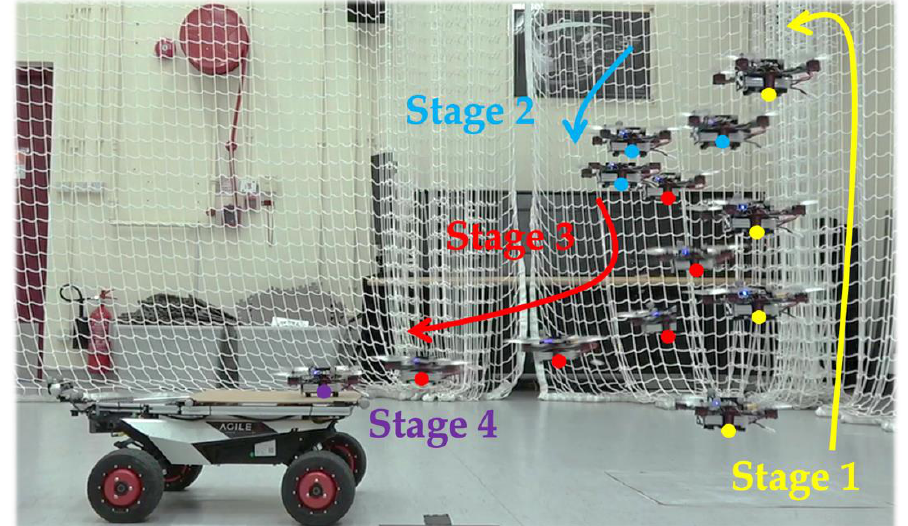
Figure 2. Schematic of the four stages of the automatic landing strategy.